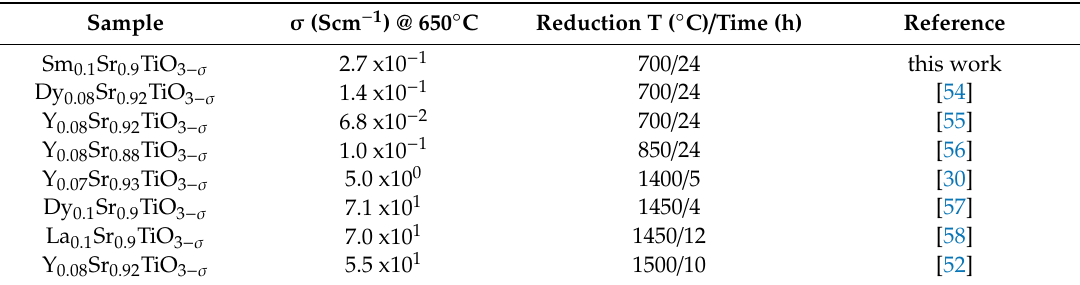
Table 3. Comparison of conductivity at 650 °C for various doped SrTiO 3 compositions after reduction. Reducing conditions and literature references are also listed.